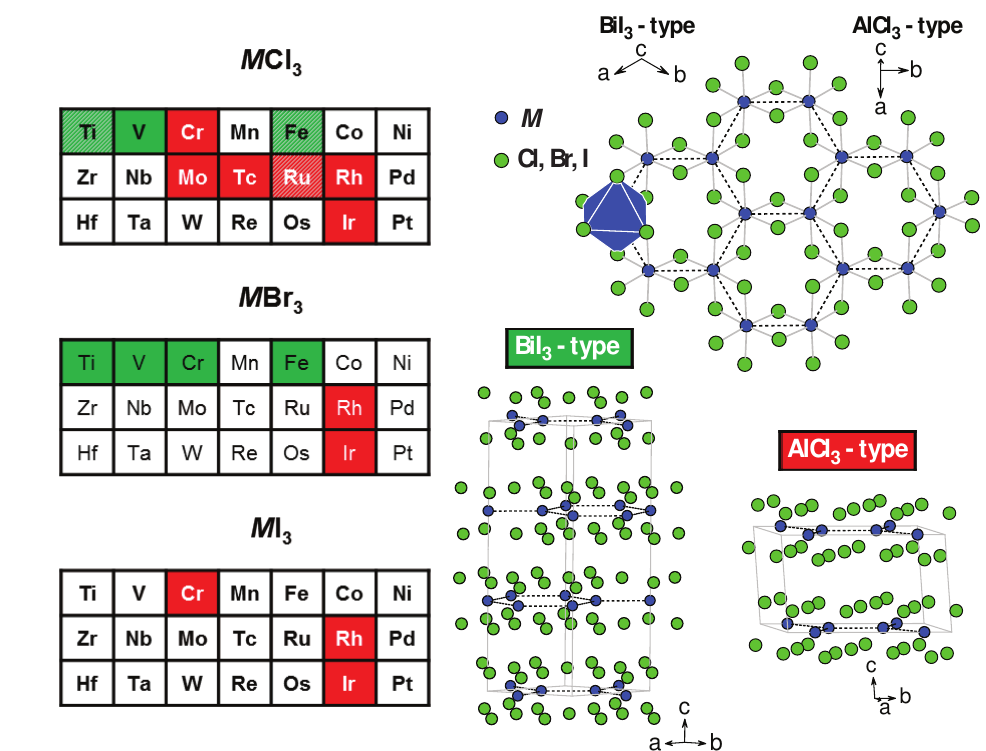
Figure 3. A section of the periodic table showing the transition metals for which layered MX 3 compounds listed in Table 2 form. The metals are highlighted with colors that correspond to the structure types shown on the lower right. Crosshatching indicates multiple structures have been reported (see Table 2). A plan view of a single layer common to both the BiI 3 and AlCl 3 structure types is shown on the upper right, with coordinate systems corresponding to each structure